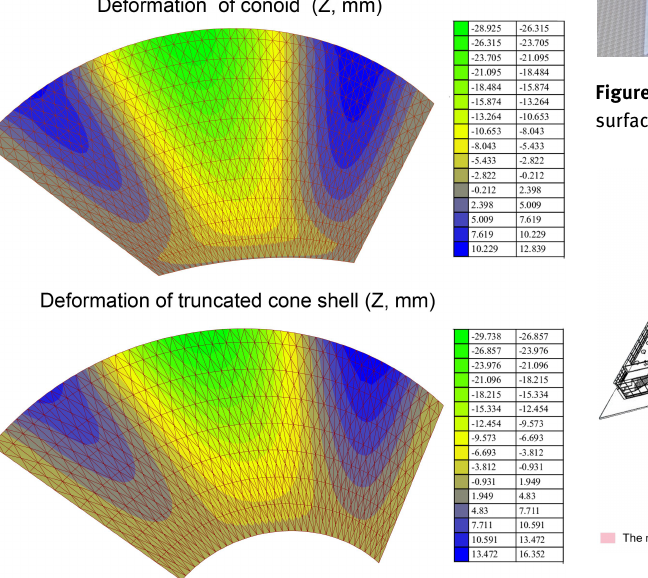
Figure 17: The structure of the concert